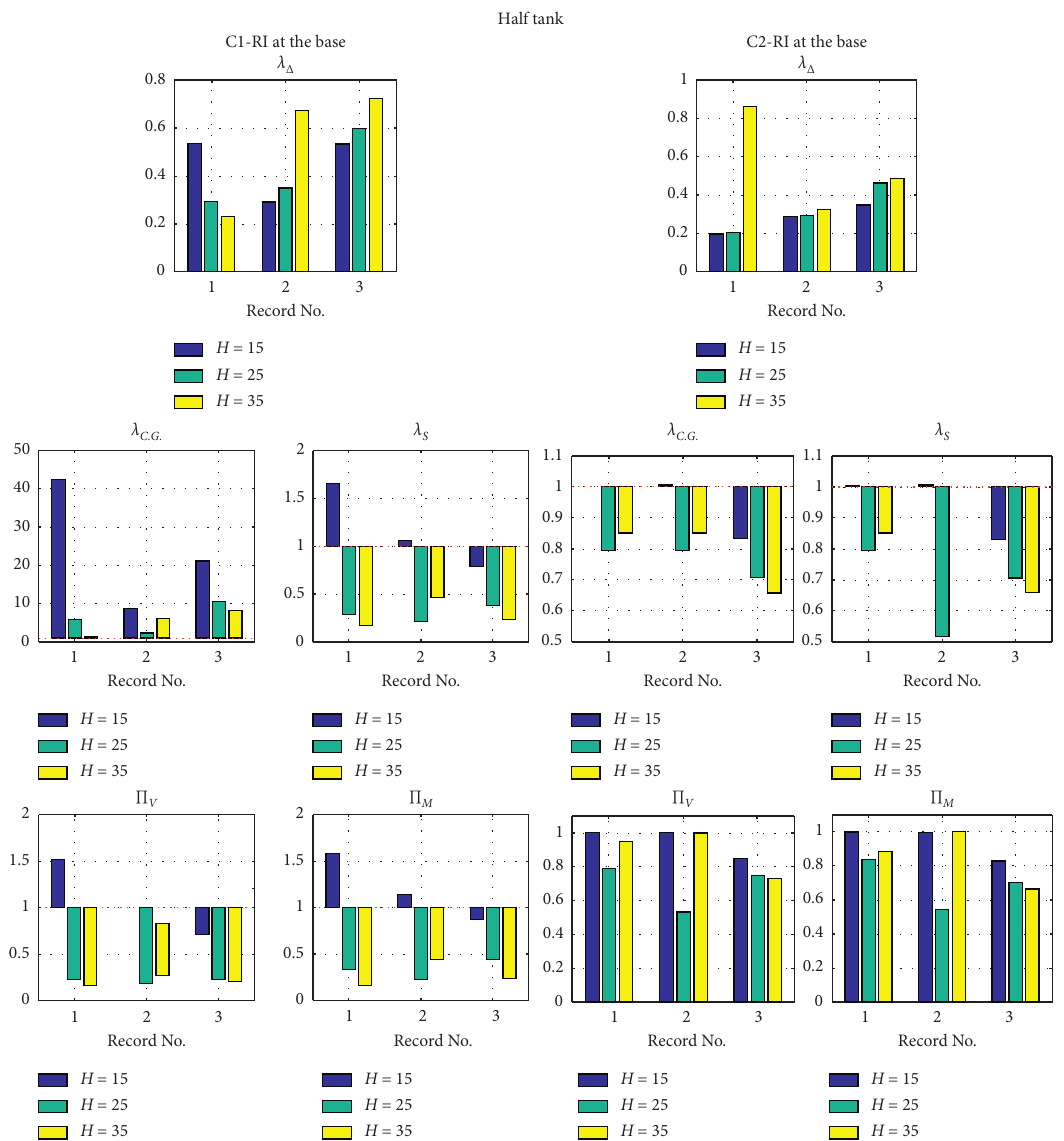
Figure 20: Performance of the prototype structures with “half tank” and various “shaft heights” (15, 25, and 35